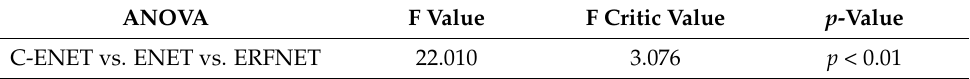
Table 3. ANOVA on the DSC showed statistical differences between DL methods.